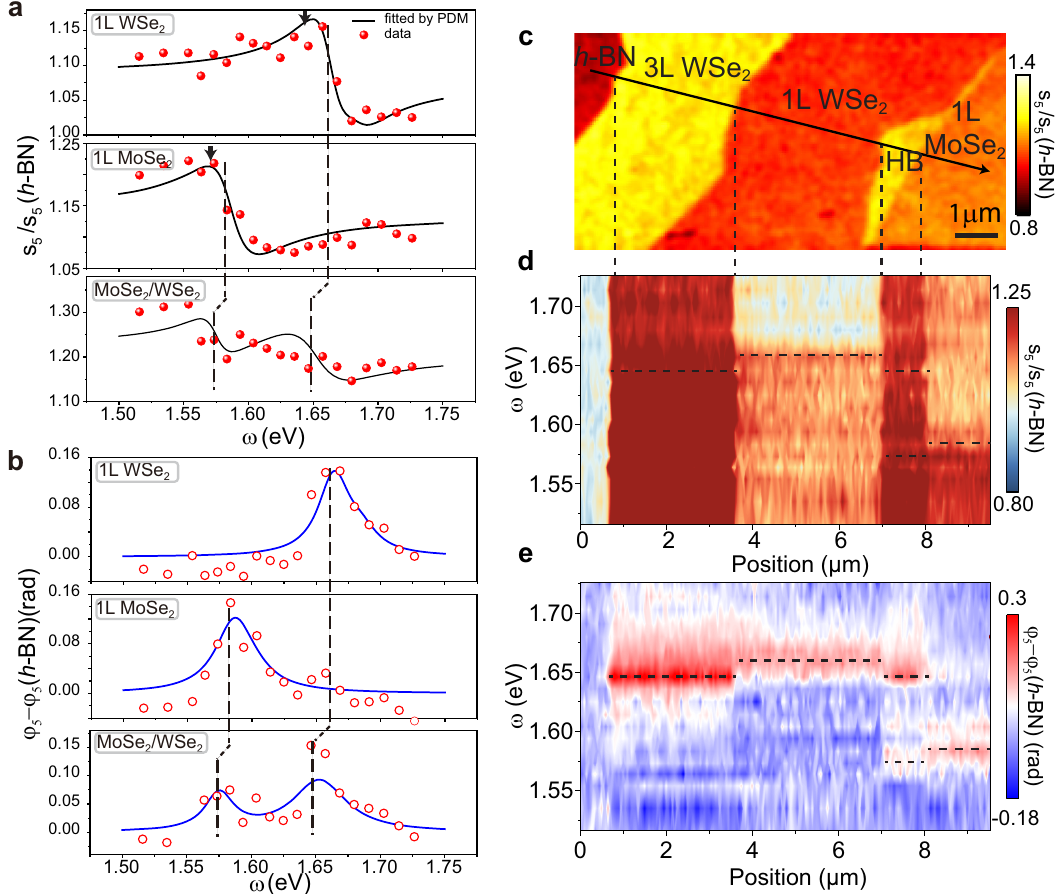
ω ð Þ (cid:2) φ h (cid:2) BN ð Þ spectra for different 5 5